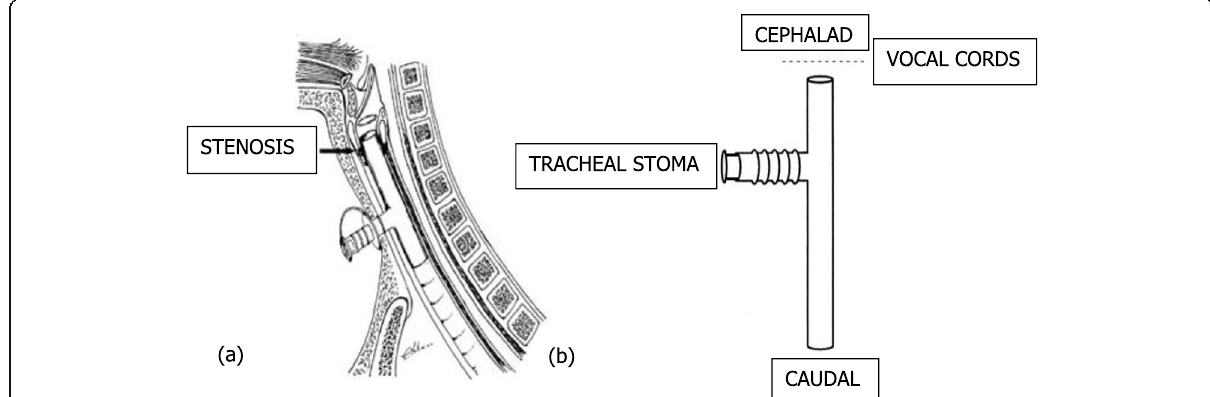
Fig. 3 The Montgomery® Safe-T-Tube ™ (Boston Medical Products,